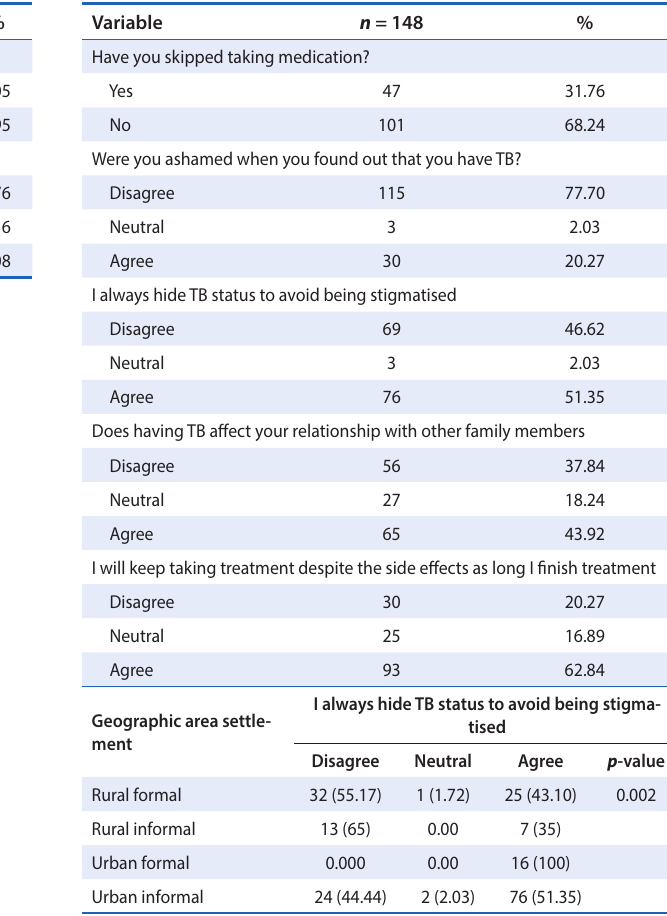
Table 4: Attitude of the respondents towards